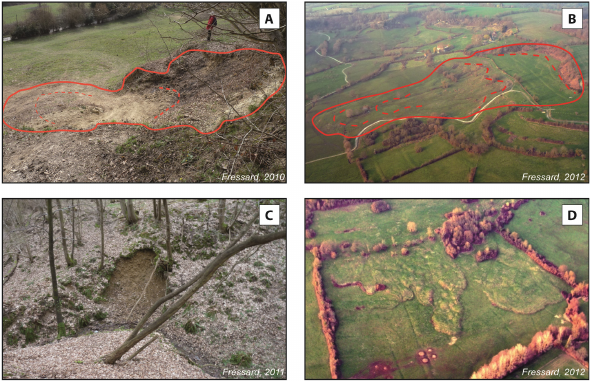
Fig. 3. Ground and oblique aerial view of typical landslides mapped in the field inventory. (A) shallow landslide, (B) deep-seated land- slide, (C) bank shallow landslide and (D)